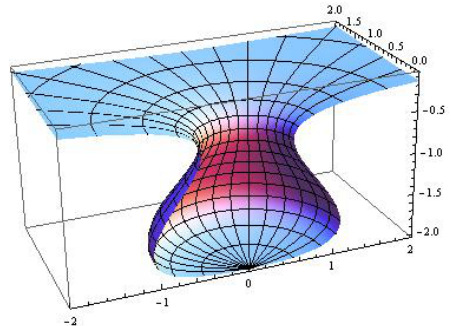
Figure 1 . The schematic sectional view of the static solution to the semi-classical Einstein equation. The neck is the local minimum of the areal radius r . The surface of the star is roughly where r has a local